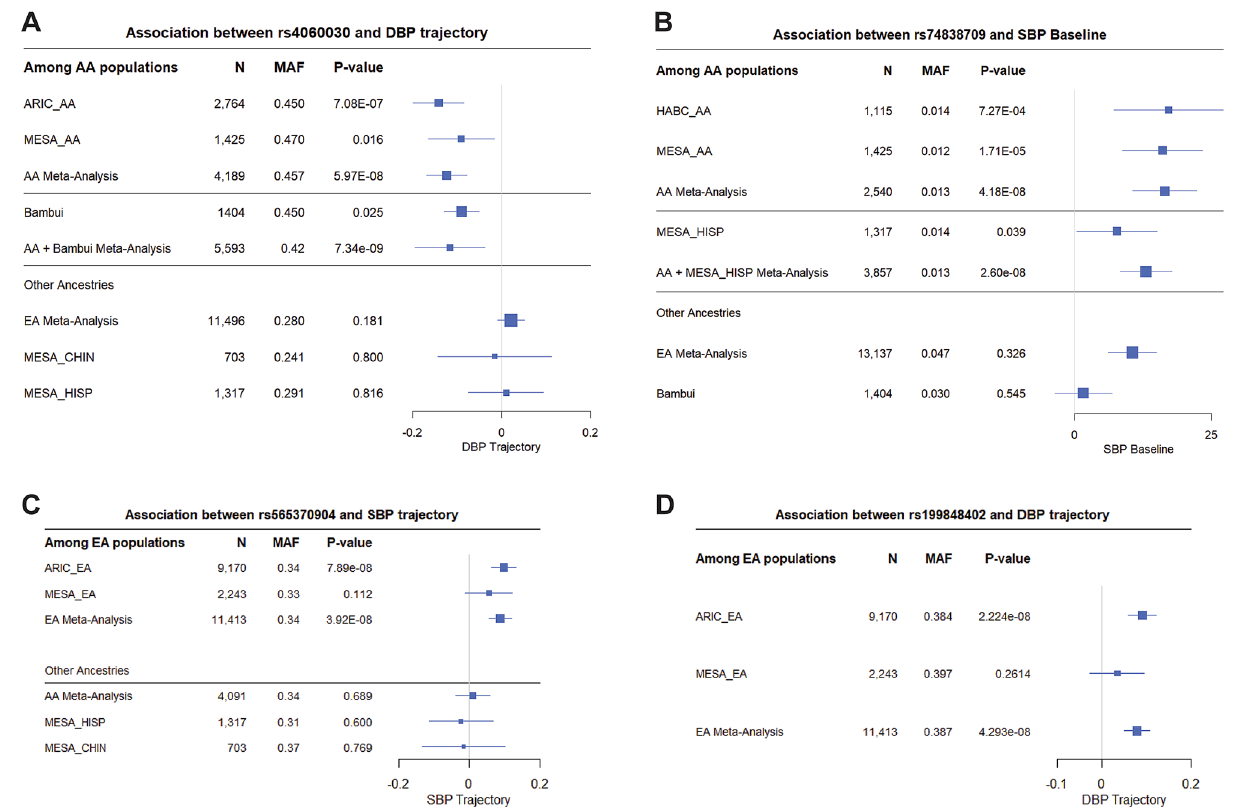
Figure 1. Forest plots of the genome-wide statistically significant associations of longitudinal and baseline BP data with additional evidence of association in independent datasets. Forest plots show β values (95% confidence intervals) and P -values from the linear regression of longitudinal outcomes (BP trajectory or BP average) adjusted for age 2 , sex, BMI, principal components (PC1 and PC2), and the use of antihypertensive medications. Populations not shown in the plots did not have the genetic variant to perform association analyses due to low allele frequency or because the variant was pruned during quality